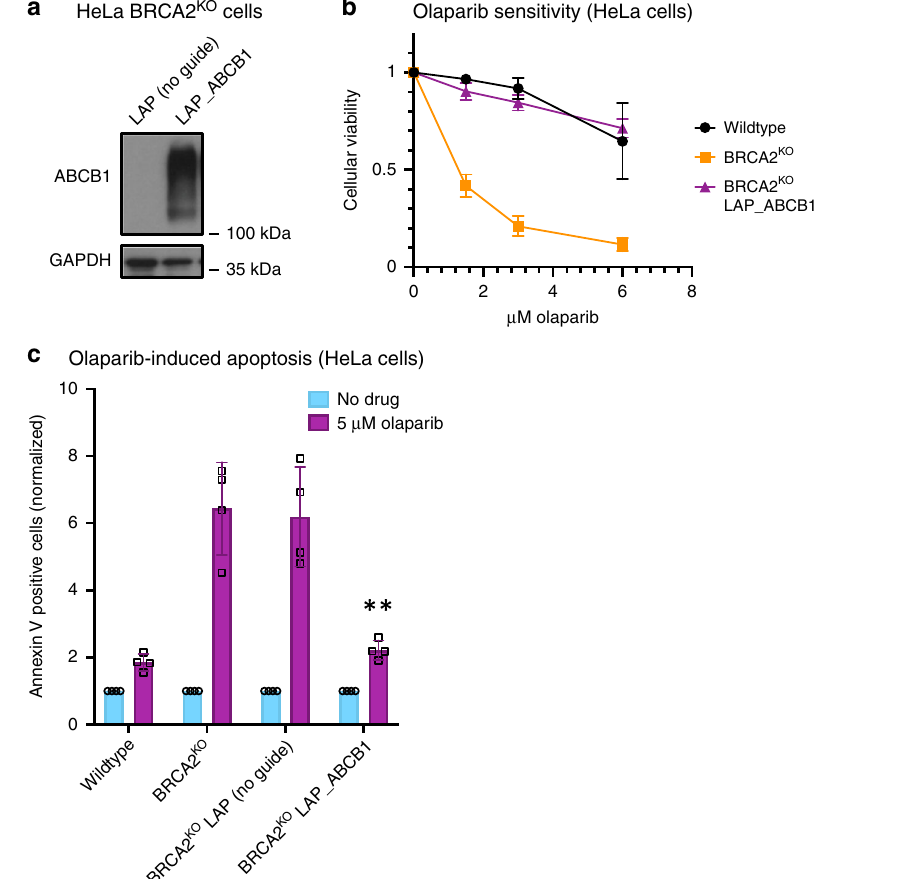
Fig. 2 Overexpression of ABCB1, the top hit from the CRISPR activation screen, causes PARPi resistance in BRCA2-de fi cient cells. a Western blot showing overexpression of ABCB1 in the cell line containing all three components of the CRISPR lentiviral activation particle (LAP) system (dCas9, activator helper complex, and sgRNA targeting the ABCB1 gene) but not in the control cell line lacking the sgRNA. b Cellular viability assay showing that ABCB1 transcriptional activation rescues PARPi sensitivity in HeLa BRCA2-knockout cells. The averages of four experiments are shown, with standard deviations as error bars. c Olaparib-induced apoptosis in BRCA2-knockout cells is suppressed by ABCB1 overexpression. The averages of four experiments are shown, with standard deviations as error bars. Asterisks indicate statistical signi fi cance ( t -test, two-tailed, unequal variance) compared to the No Guide sample. Source data are provided as a Source Data fi